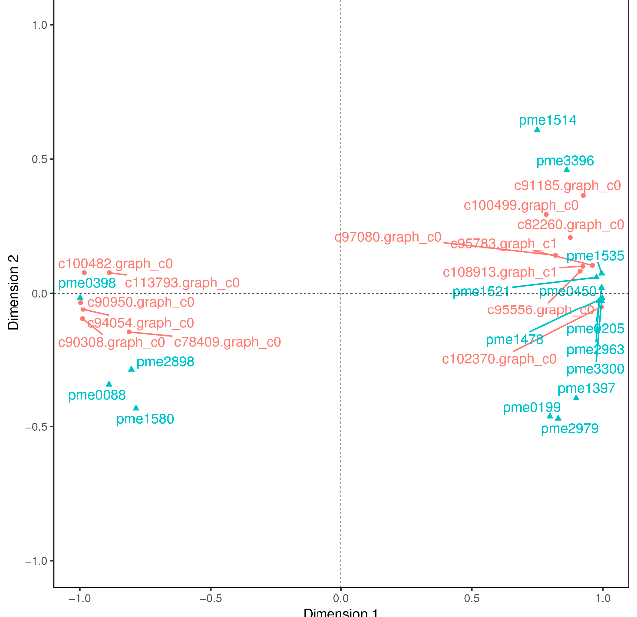
Figure 6. Canonical correlation analysis of differential genes and metabolites in T. hemsleyanum . The red color represents the gene ID, and the blue indicates its meta name. The genes annotations infor ‐